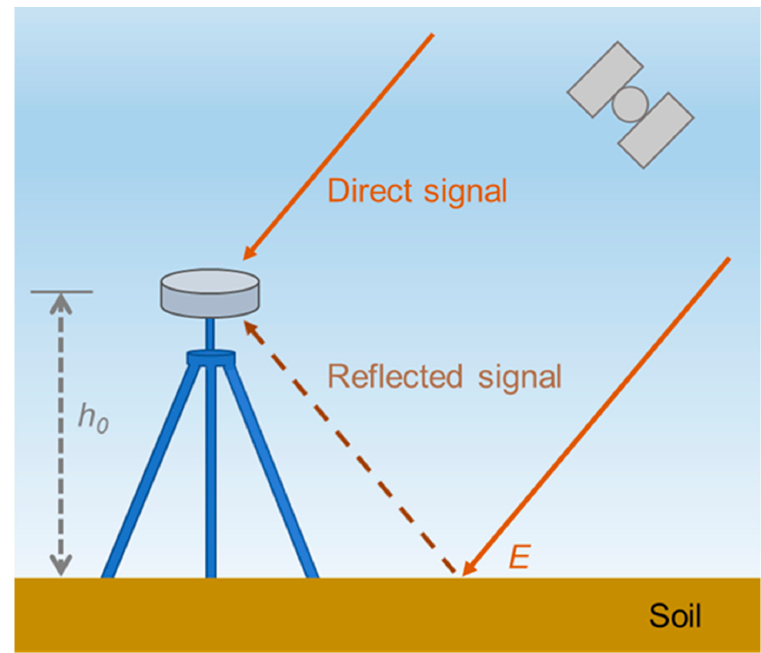
Figure 2. Typical multipath reflection geometry of GNSS-IR.